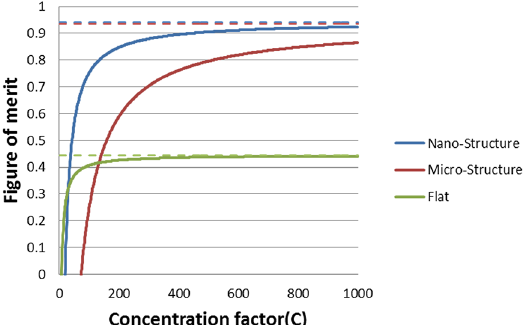
Figure 11. Figure of merit for three kinds of